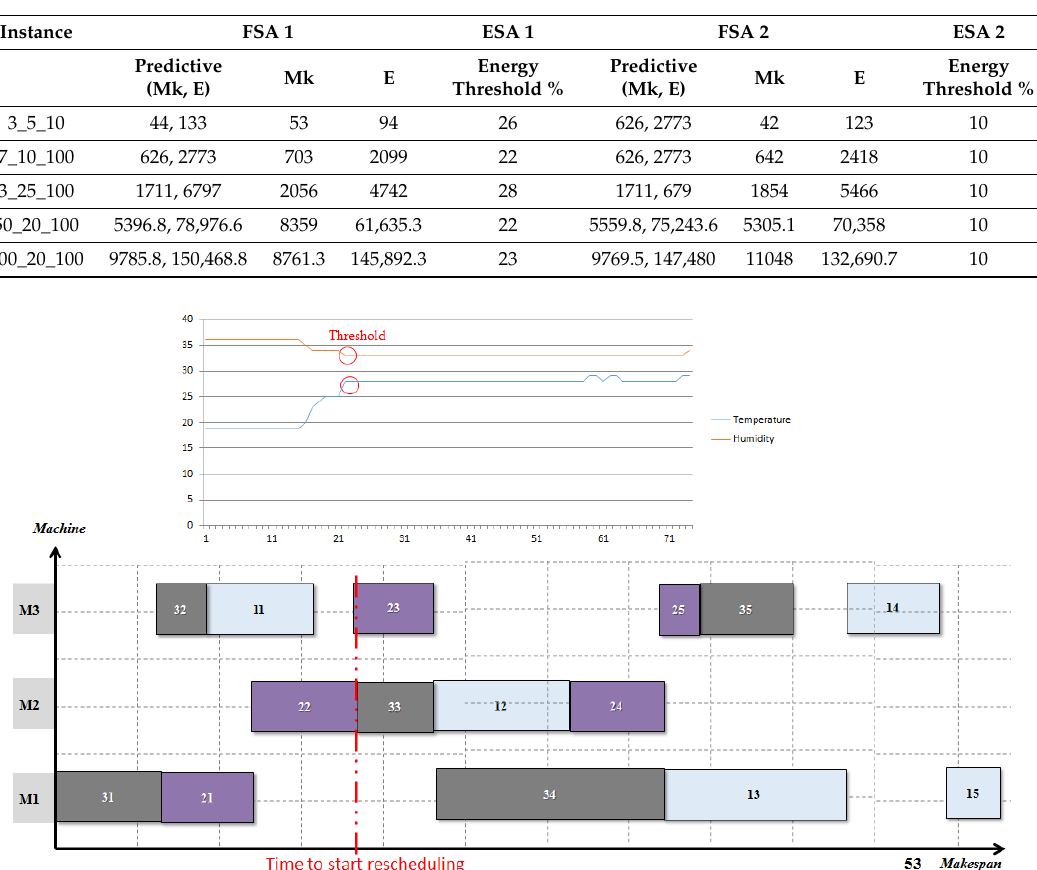
Table 3. Results of the reactive part.